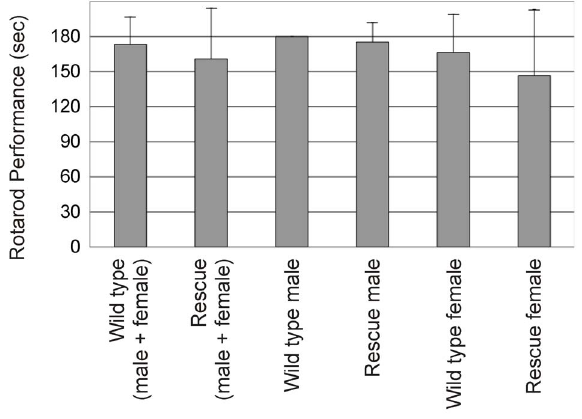
Figure 4. Rotarod analysis. Locomotor function was assessed by rotarod analysis. Performance is rated as time on rotarod with 180 seconds maximum. Four male and four female wild type and FXN-EGFP rescue mice ( FXN-EGFP + , Fxn 2 / 2 ) at 12 months of age were analyzed. Error bars represent standard error of the mean.